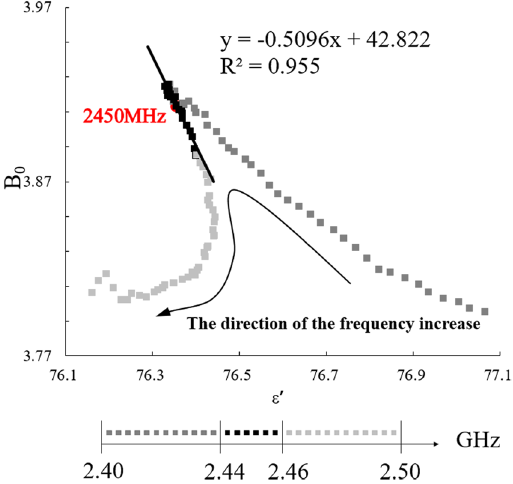
Figure 5. Change curve of starch–water mixtures with B 0 ( = ε″ f B / (25 °C).